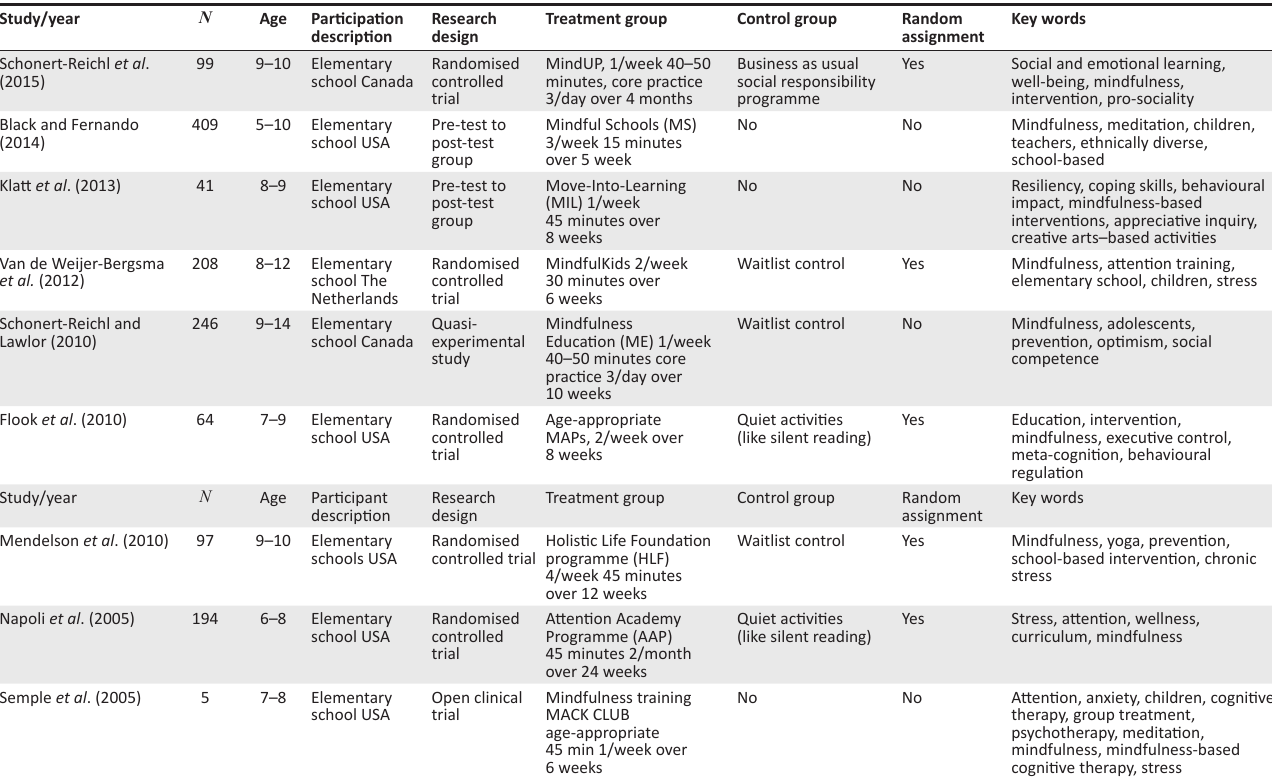
TABLE 1: Mindfulness-based interventions with children.